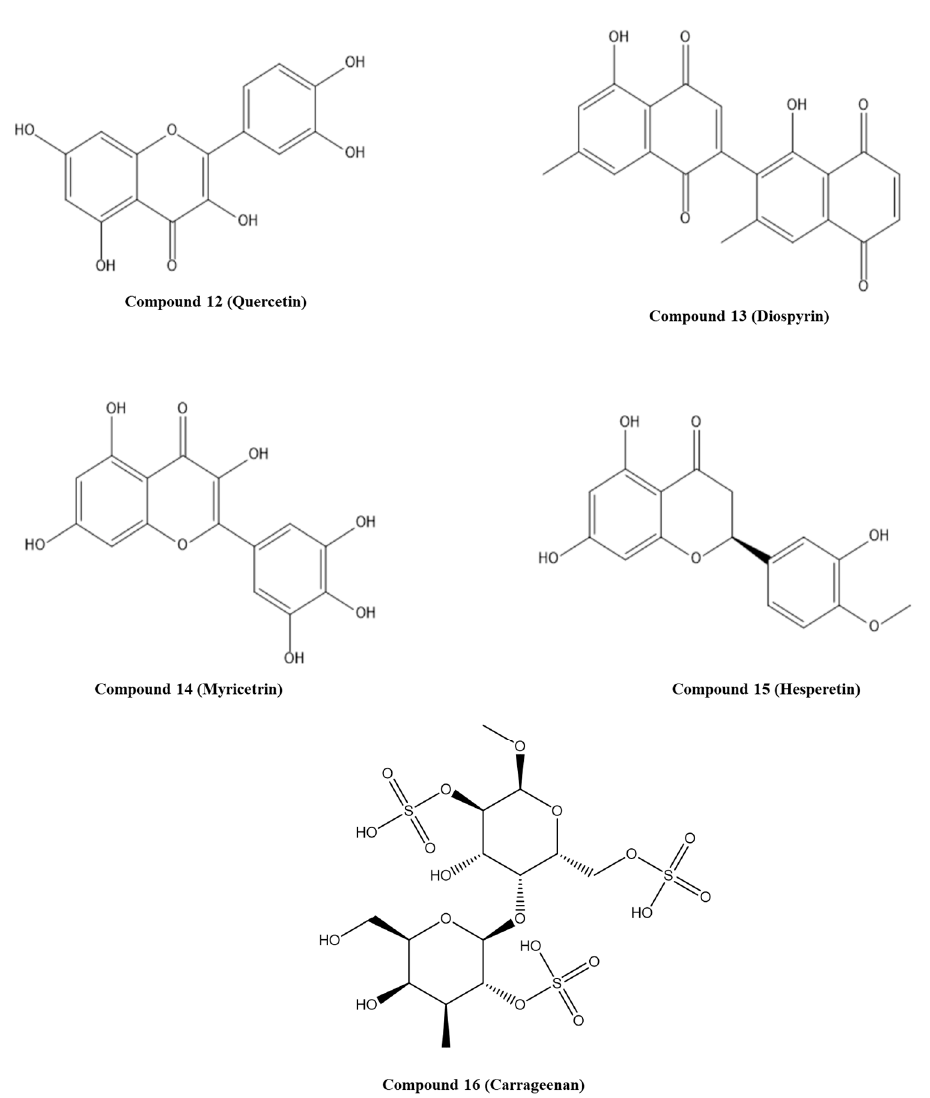
Figure 4. Structures of the studied natural compounds as E6/E6AP inhibitors. IUPAC name of com ‐ pounds—compound 12 : 2 ‐ (3,4 ‐ dihydroxyphenyl) ‐ 3,5,7 ‐ trihydroxy ‐ 4 H ‐ chromen ‐ 4 ‐ one; compound 13 : 1’,5 ‐ dihydroxy ‐ 3’,7 ‐ dimethyl ‐ [2,2’ ‐ binaphthalene] ‐ 1,4,5’,8’ ‐ tetraone; compound 14 : ( S ) ‐ 5,7 ‐ dihy